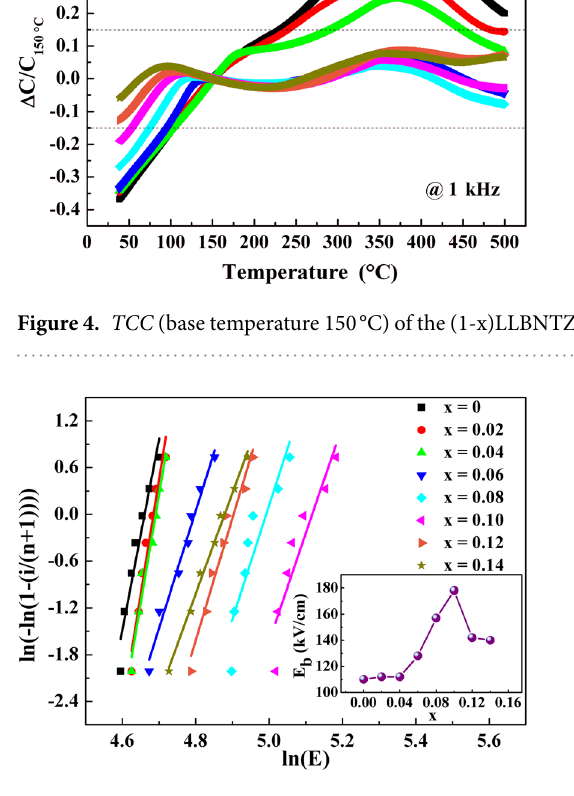
Figure 5. Weibull distribution of BDS for the (1-x)LLBNTZ-xNBN ceramics. (The inset shows BDS as a function of x for the (1-x)LLBNTZ-xNBN